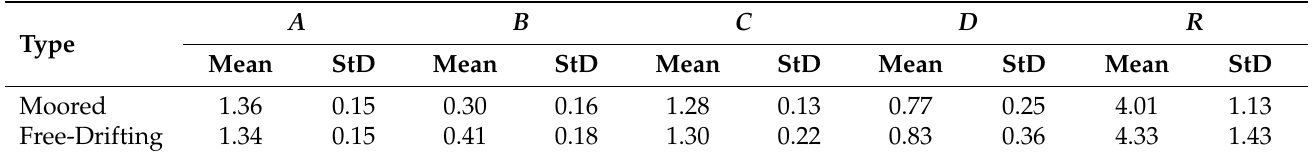
Table 5. Mean and standard deviation for the five characteristic points defining the wave signature for impacts by spilling breakers with the buoy moored and free-drifting in the surf zone. Points A through D have units of acceleration/g, while the R column is the maximum magnitude of pitch and roll rotational rate recorded during the breaking event having units of